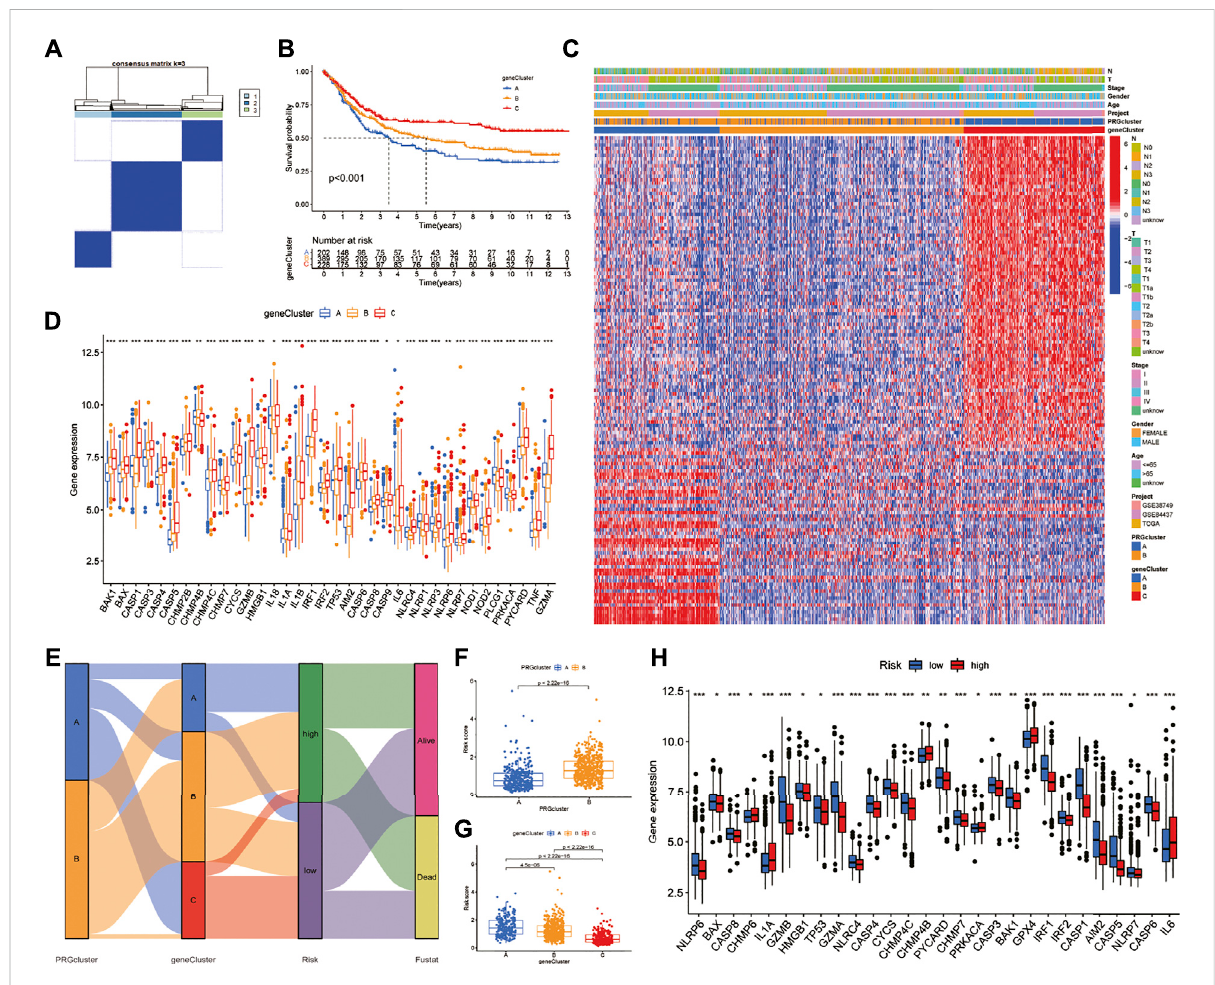
FIGURE 4 Identi fi cationofDEGsubtypesandconstructionoftheprognosticmodel (A) Consensusunsupervisedclusteringde fi nestwoclusters( k =3)and theircorrelationarea (B) Kaplan-MeiersurvivalcurvesbetweenthethreeDEG-relatedsubtypes (C) Differencesinclinicalcharacteristicsbetweenthe threeDEG-relatedsubtypes (D) ExpressiondifferencesofPRGsbetweenthethreeDEG-relatedsubtypes (E) Alluvialdiagramofsubtypedistributions in groups with different PRG scores and survival outcomes (F,G) Differences in RS with respect to different phenotypes (H) Differential expression of PRGs in the high-and low-risk groups. RS: risk score.